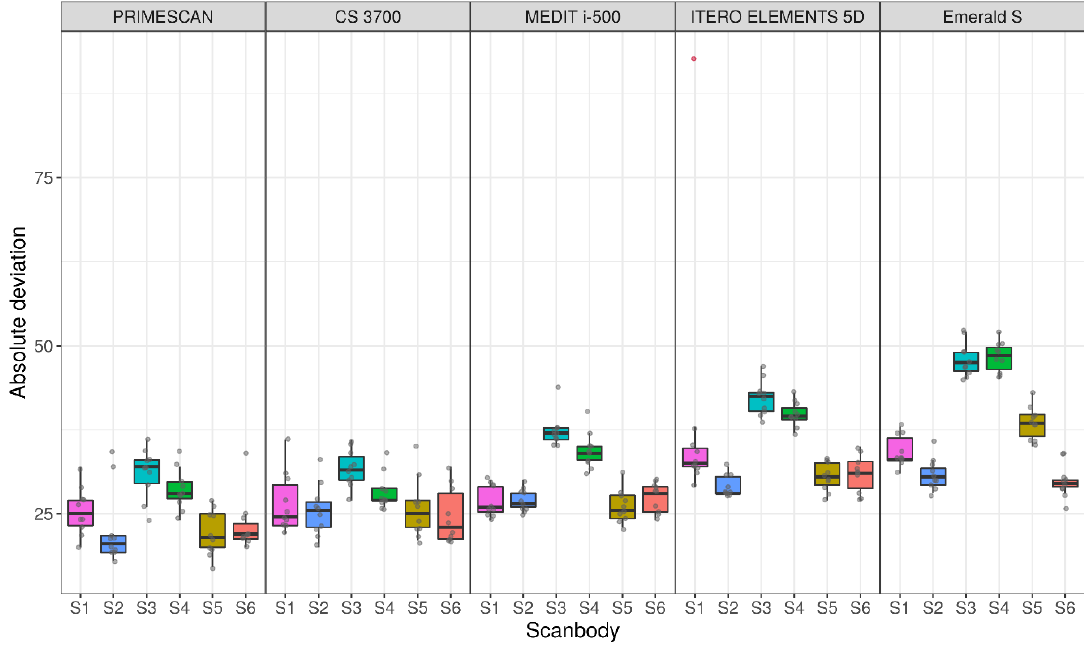
Figure 4. Sample distributions of absolute deviations across IOS and scanbody (SB), in μ m.